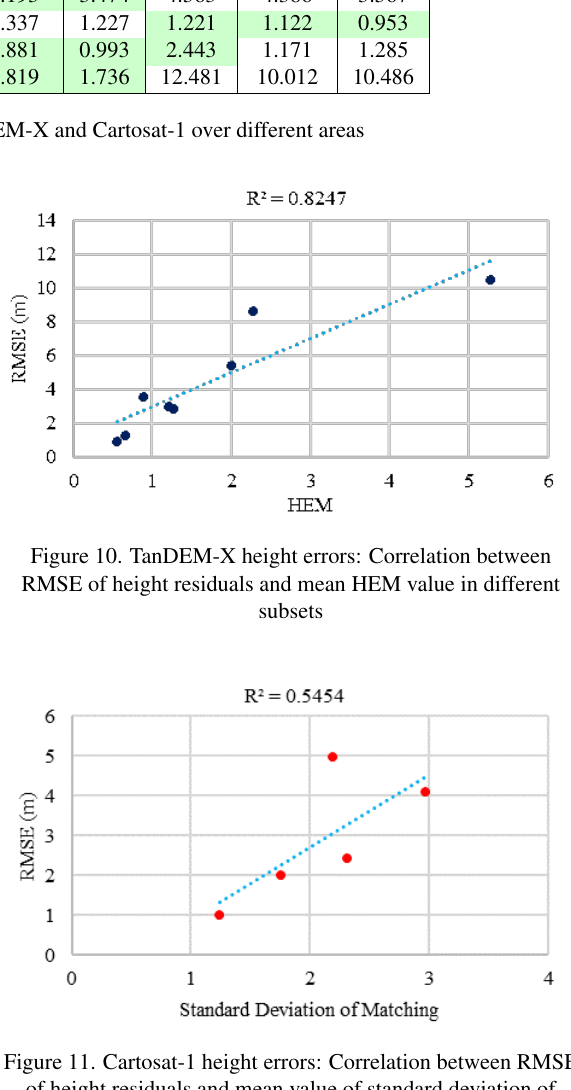
4.3.2 ANN-based Fusion Results: The size of data for